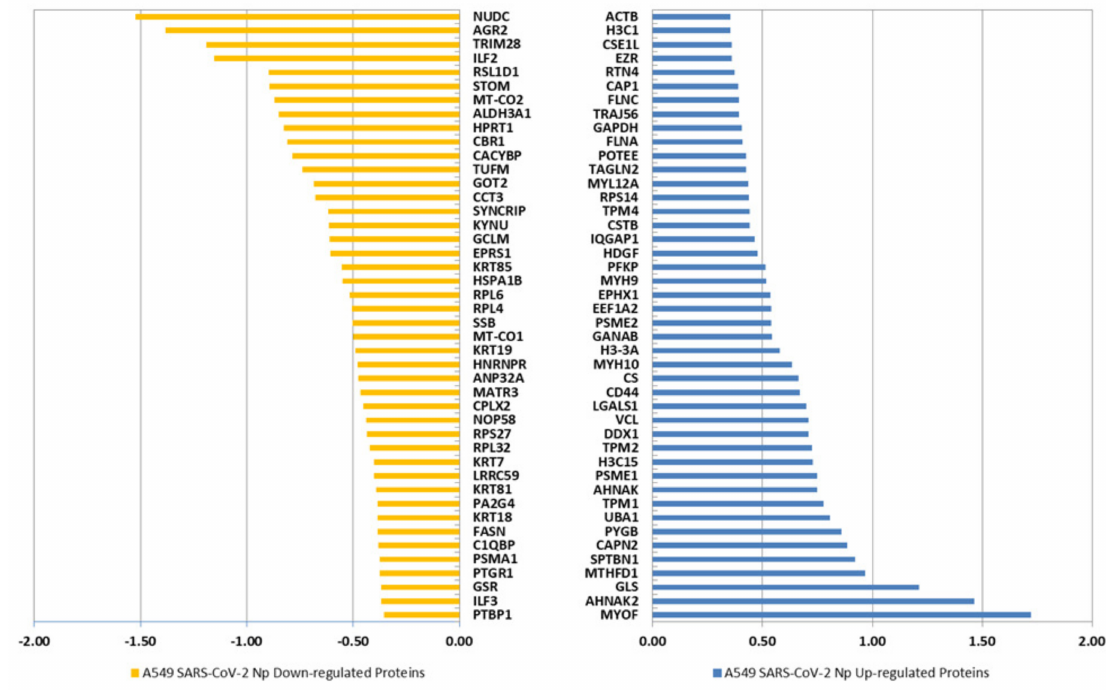
Figure 2. Differentially expressed proteins identified in A549 cells expressing an empty vector and SARS-CoV-2 N protein through label-free quantification with MAProMa software. Orange bars and negative DAve values refer to down-regulated proteins in A549 transfected with SARS-CoV-2 N protein, while light blue bars and positive DAve values refer to up-regulated proteins in A549 cells transfected with SARS-CoV-2 N protein. For each protein, the gene name and related DAve value (ratio of protein expression) are